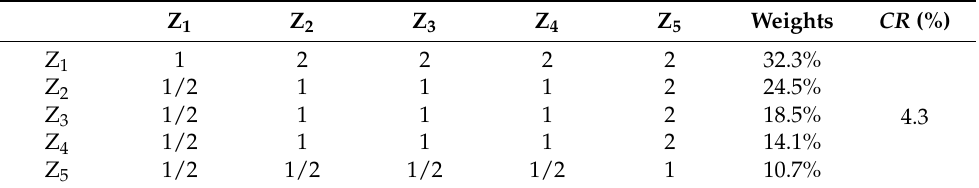
Table 6. Decision matrix of various fire-risk zones. (Z1 is general risk zone; Z2 is flammable and